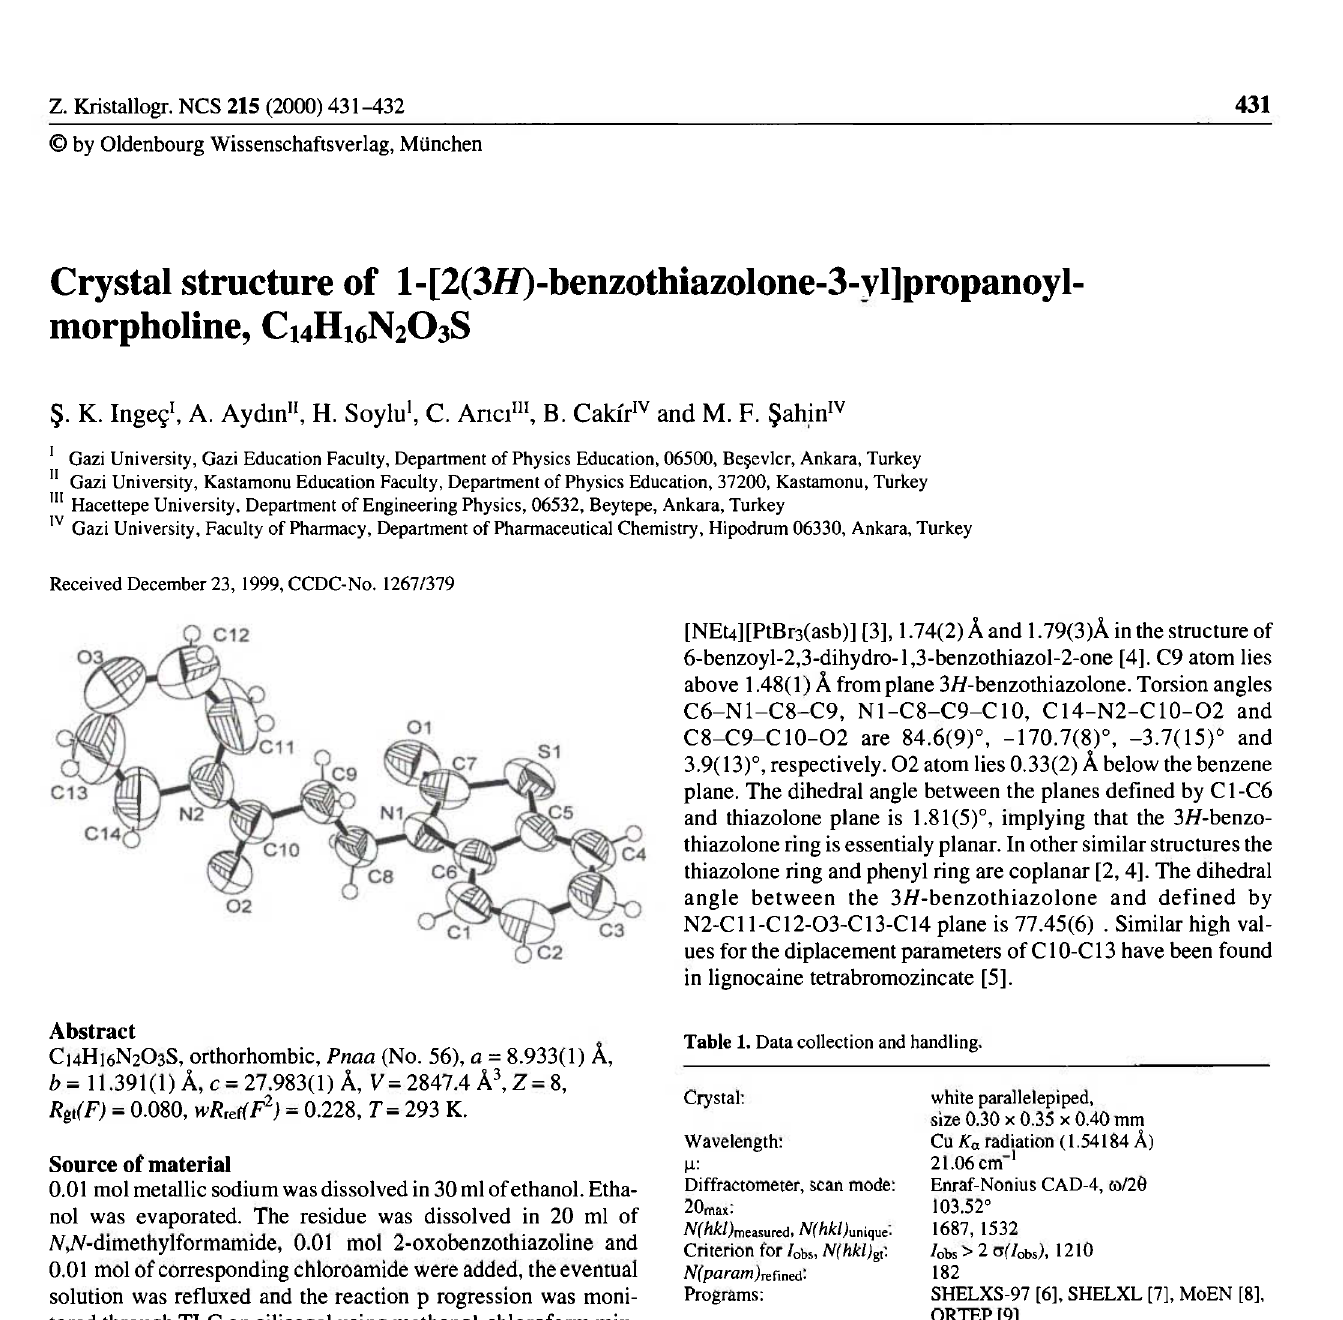
Table 2. Atomic coordinates and displacement parameters (in A 2